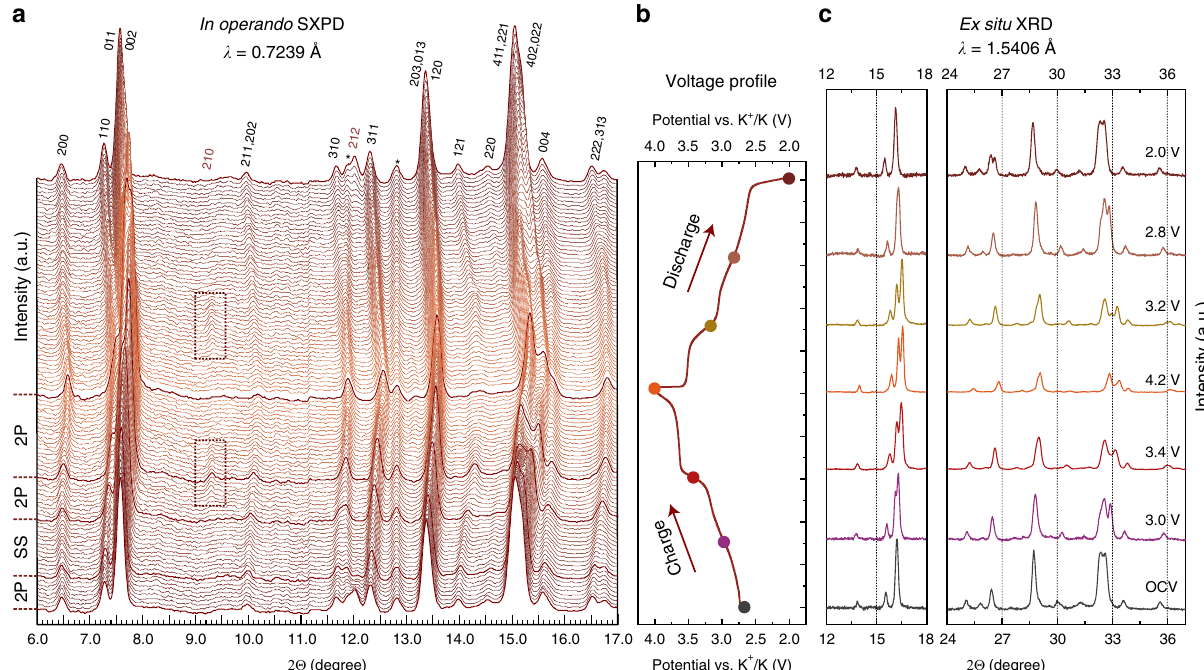
Fig. 3 In operando and ex situ diffraction studies of KTiPO 4 F. a Diffraction patterns of the in operando SXPD of KTiPO 4 F in K cell in the 6 – 17° 2 Θ range ( λ = 0.7239 Å). b Corresponding charge-discharge pro fi le. Indexed re fl ections are denoted. The highlighted dark-red XRD patterns show tentative boundaries of the two-phase (2P) or solid solution (SS) deintercalation regimes on charge. The discharge behavior of KTiPO 4 F can be considered symmetric. The asterisk sign (*) designates steady re fl ections belonging to cell components. c Selected regions of the ex situ XRD patterns of electrodes recovered at various potentials (charge/discharge at C/20 rate, hold for 20 h at every